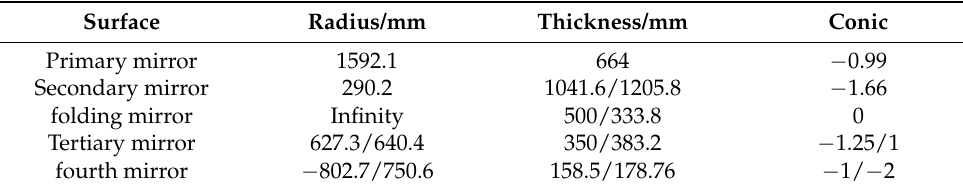
Table 5. Initial parameters of the reflective